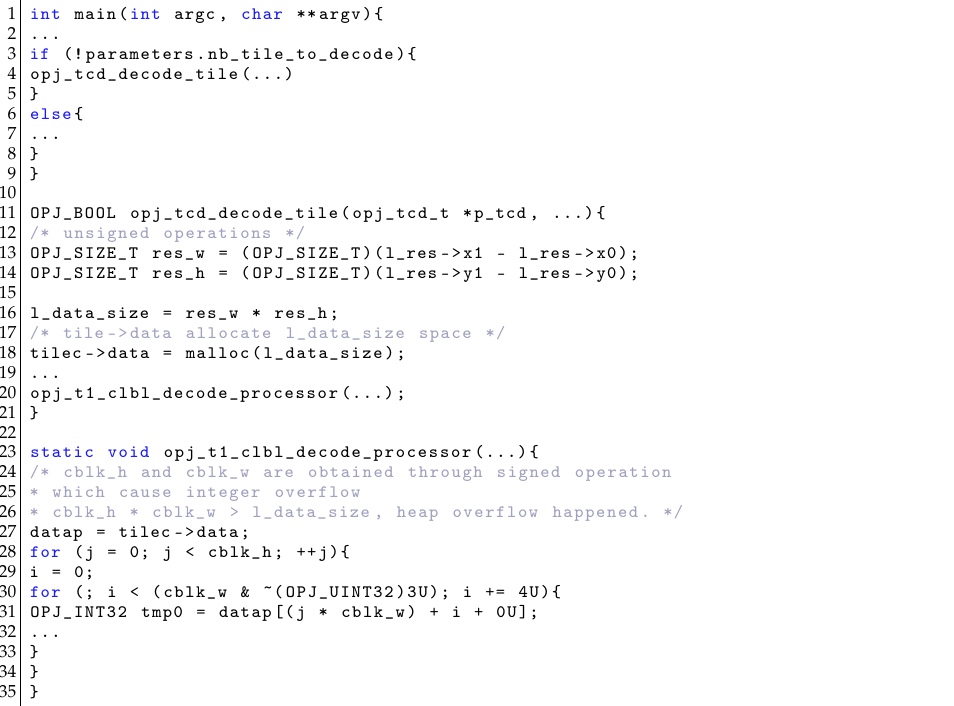
Figure 5. An example from openjpeg